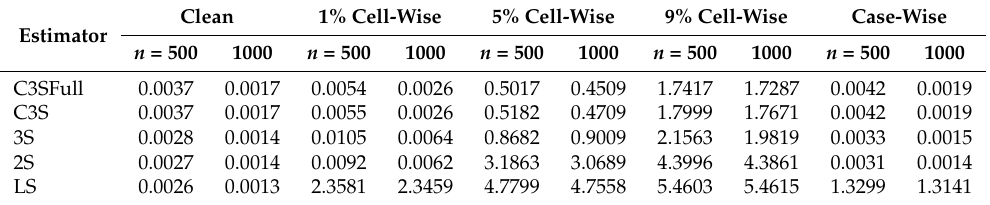
Table 2. Maximum MSE in all of the considered scenarios for models with continuous covariates.